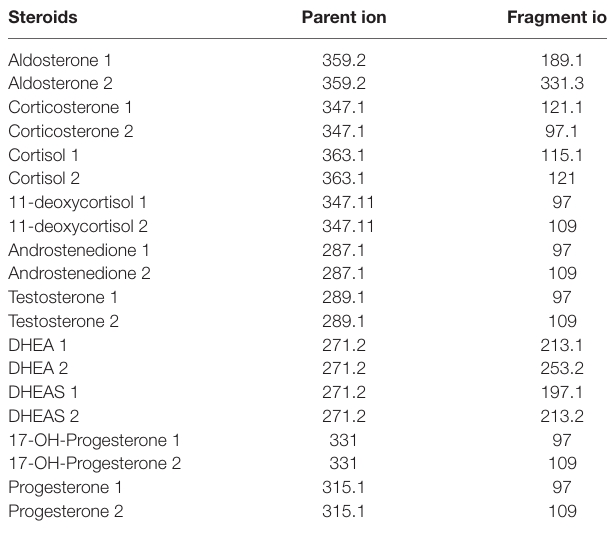
TaBle 2 | Table reporting the mass spectrometry (MS)/MS MRM analyte